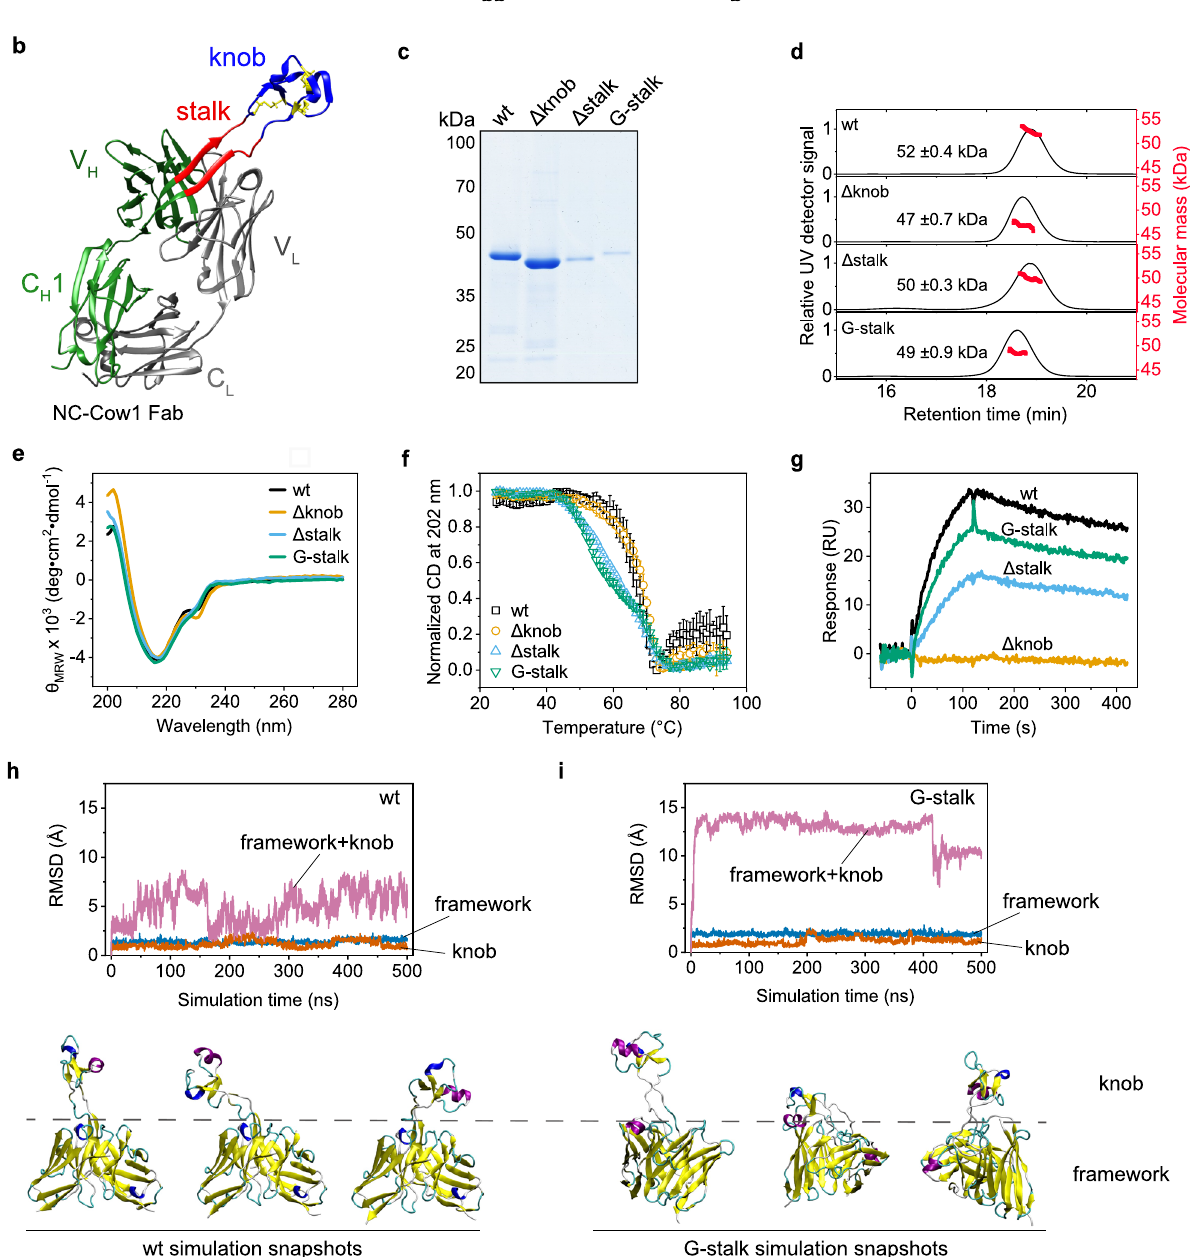
Fig. 1 Importance of the stalk and knob in the ultra-long CDR-H3. a Sequences of NC-Cow1 mutants with differences in the ultra-long CDR-H3. b Crystal structure of NC-Cow1 Fab (PDB:6OO0). c Immunoprecipitation of Expi293 supernatants after transient expression of the Fab fragments followed by SDS- PAGE. Two independent experiments. d SEC MALS chromatograms of the puri fi ed NC-Cow1 Fab variants (the molecular mass is shown in red; the value is mean of triplicates with standard deviation). e FUV CD spectra and f thermal stability of the NC-Cow1 Fab variants (the points represent the mean of triplicates with standard deviation). g Binding of 100 nM NC-Cow1 Fab variants to the immobilized HIV-1 Env protein as determined by SPR. In e , f and g , black is the wildtype (wt) NC-Cow1 Fab, orange is the mutant with deleted knob ( Δ knob), blue is the mutant with deleted stalk ( Δ stalk), and green is the mutant with a stalk made of glycine residues (G-stalk). h and i Comparative MD-simulation on the Fv of NC-Cow1 wt ( h ) and G-stalk ( i ) showing the RMSD deviation (with respect to experimental start structure) of the Fv framework alone (blue), the knob alone (orange), or the motion of the whole structure (knob plus the Fv framework, magenta). Simulation snapshots at different phases of the simulation are indicated.